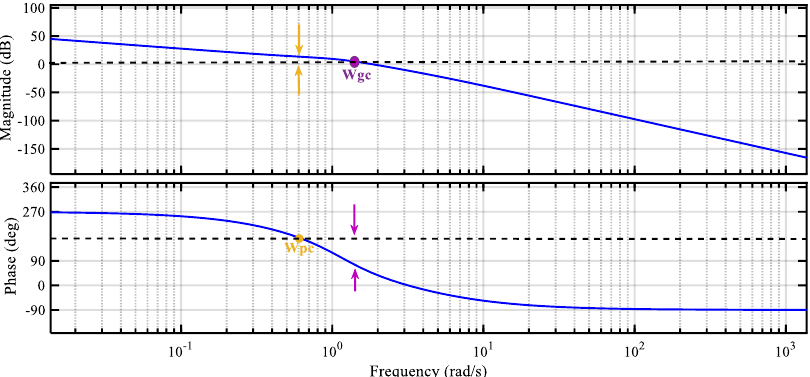
Figure 3. Gain and phase margin of an LFC system containing a delayed EV aggregator.